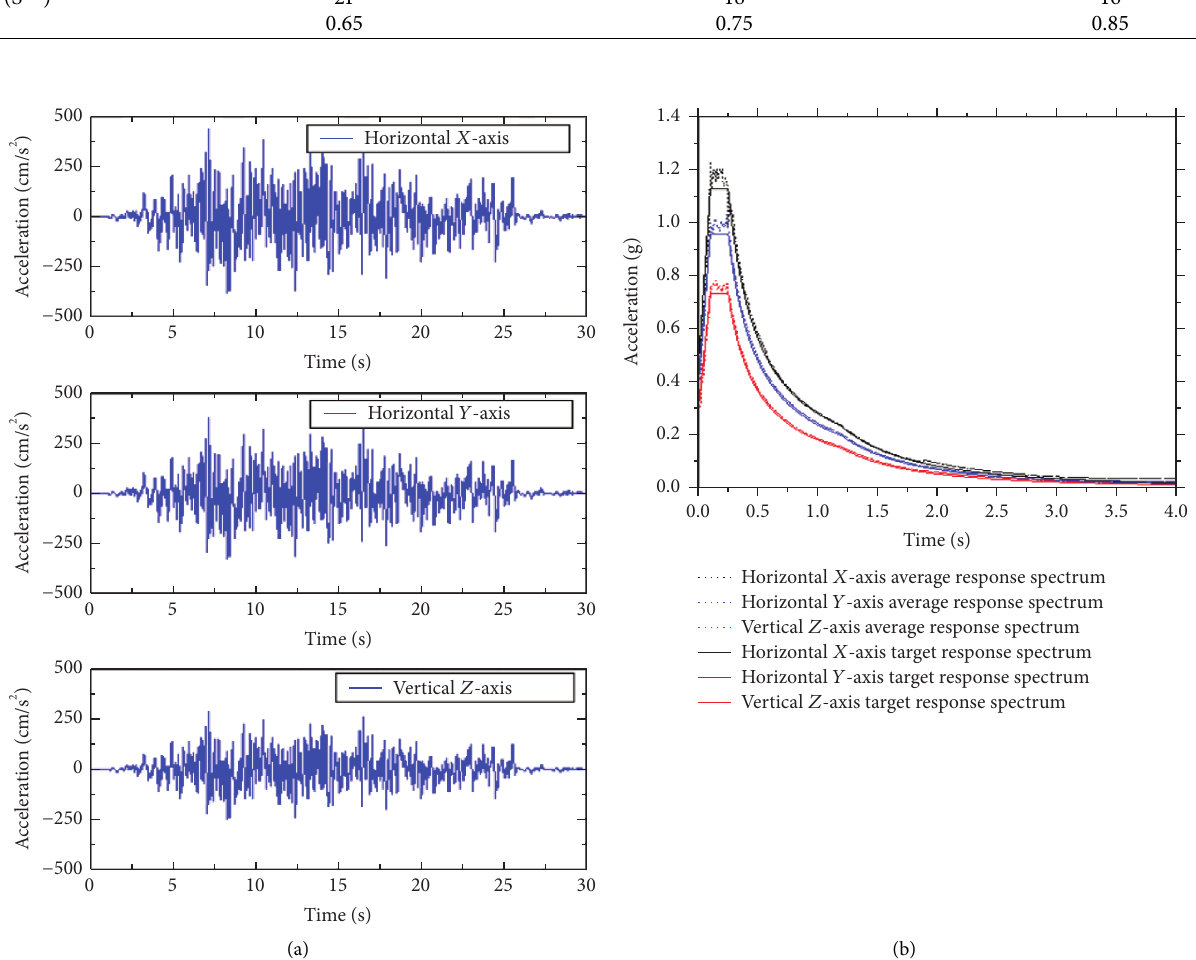
Figure 4: (a) Three-dimensional representative time history and (b) comparison with three-dimensional target response spectrum before iteration.